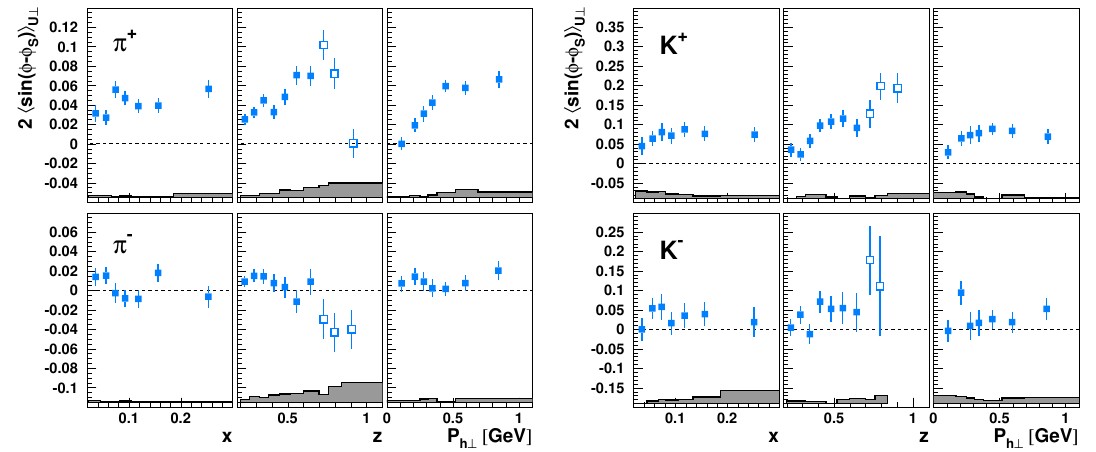
Figure 12 . Sivers SFA for charged mesons (left: pions; right: kaons) presented either in bins of x , z , or P h ⊥ . Data at large values of z , marked by open points in the z projection, are not included in the other projections. Systematic uncertainties are given as bands, not including the additional scale uncertainty of 7.3% due to the precision of the target-polarization